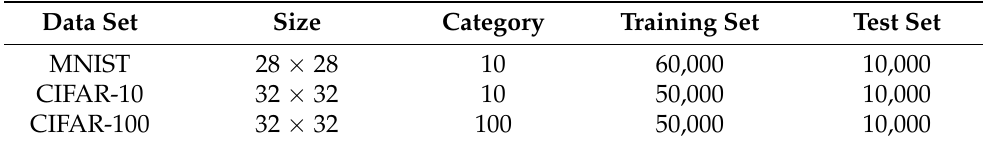
Table 2. Description of the image data set.